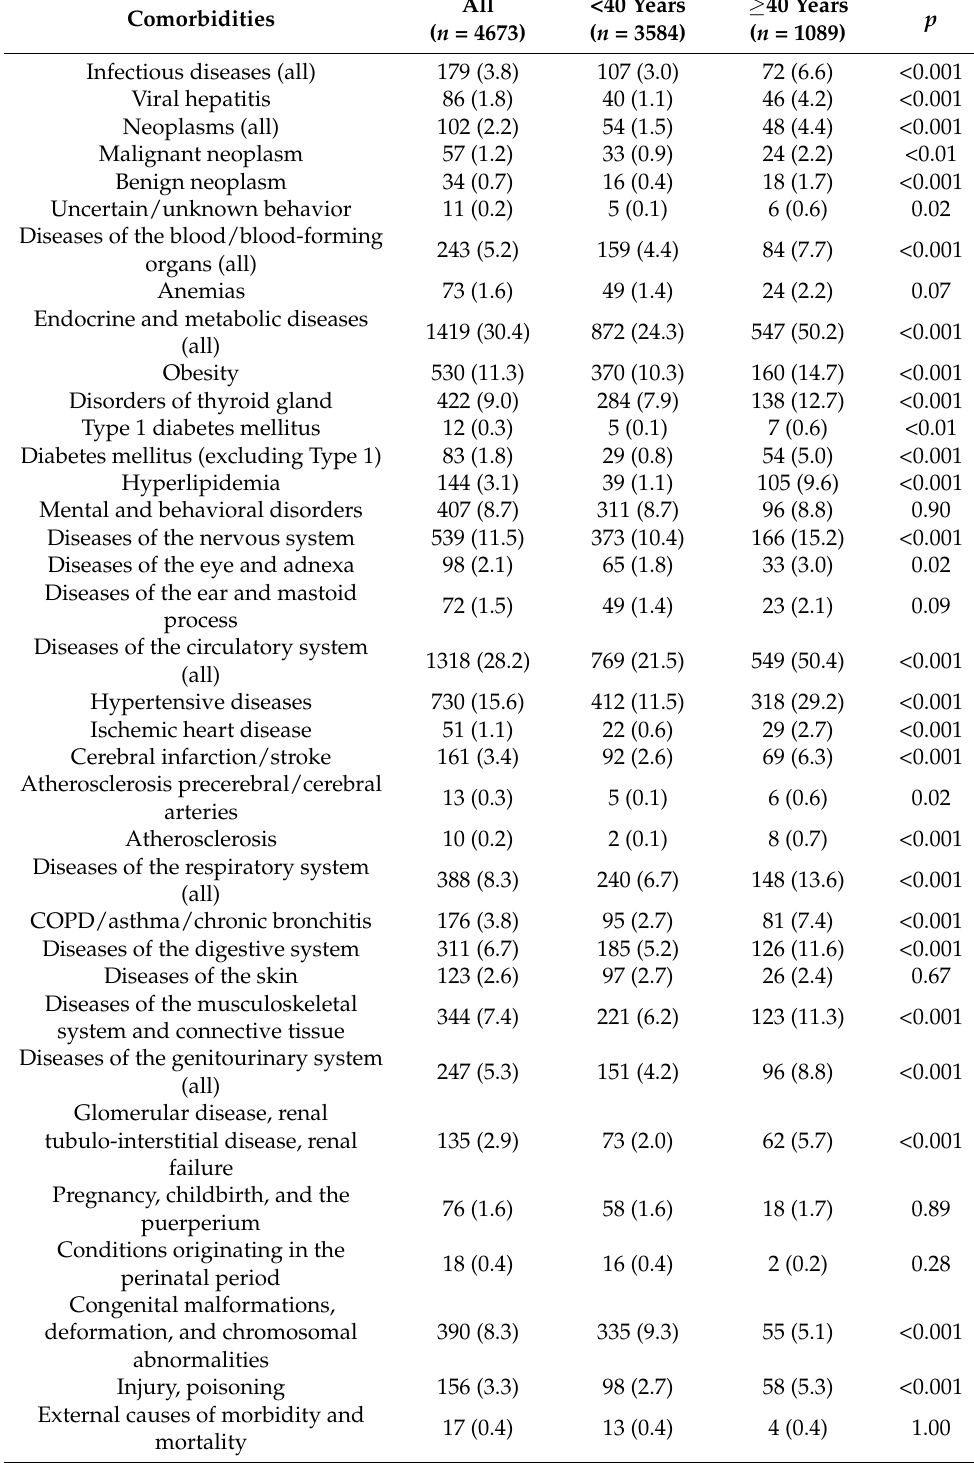
Table 2. Prevalence of comorbidities, n